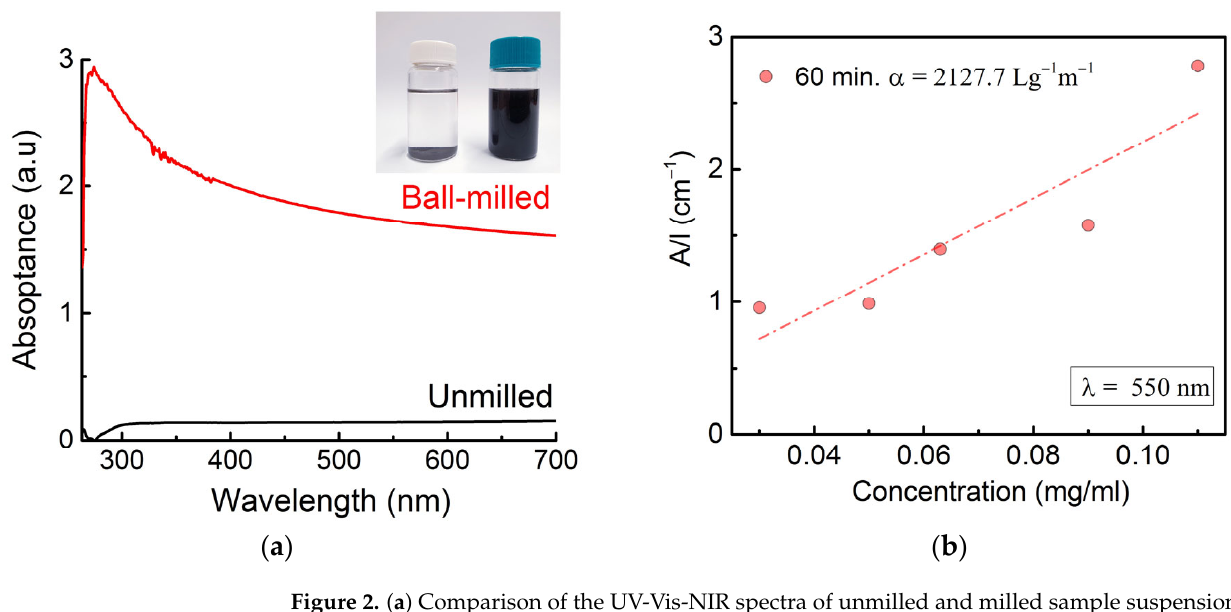
Figure 2. ( a ) Comparison of the UV-Vis-NIR spectra of unmilled and milled sample suspensions in DMF (The inset in Figure 2a Photographs of dispersions of unmilled (left vial) and milled powders (right vial) in DMF), and ( b ) optical absorbance at λ = 550 nm divided by cell length (A/l) versus concentration of the ball ‐ milled sample.